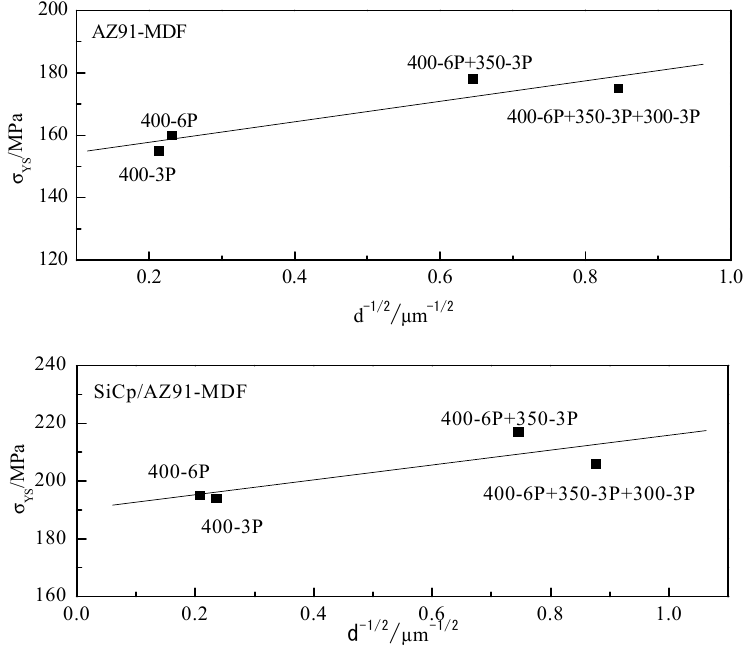
Figure 10. Relationship between yield strength σ YS and inverse square root d − 1/2 of grain size in AZ91 alloy and nano-SiCp/AZ91composites after multi-pass forging for different passes.